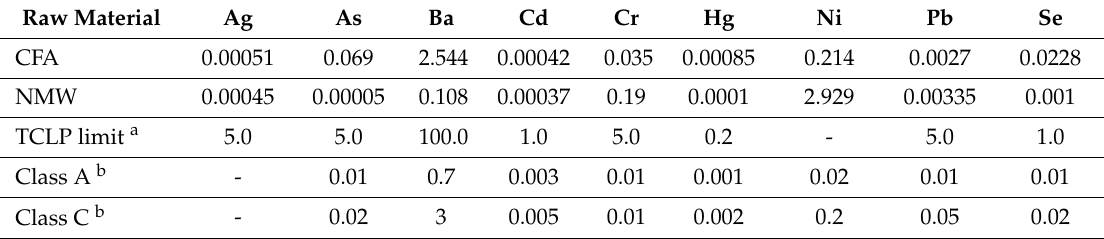
Table 4. Toxicity characteristic leaching procedure (TCLP) Analysis of raw materials samples in mg /